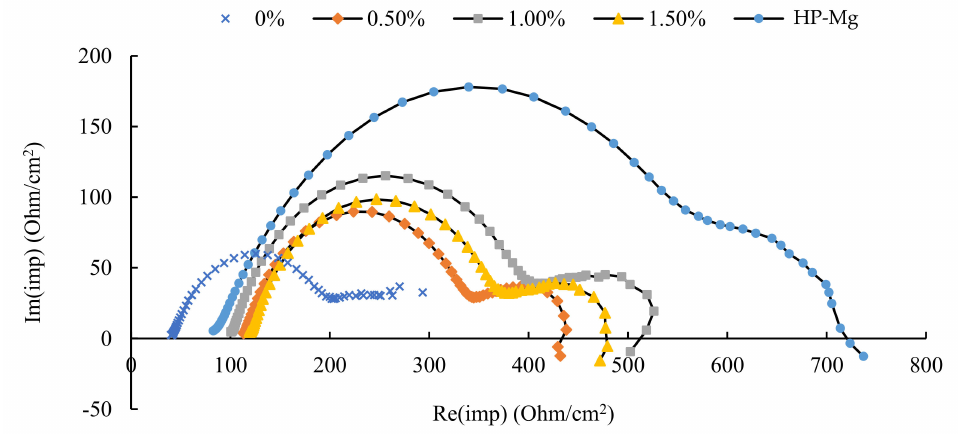
Figure 6. Nyquist plots of the measured impedances for the Mg-SiO 2 nanocomposites group. Table 3. Summary of electrochemical corrosion characteristics of Mg-SiO 2